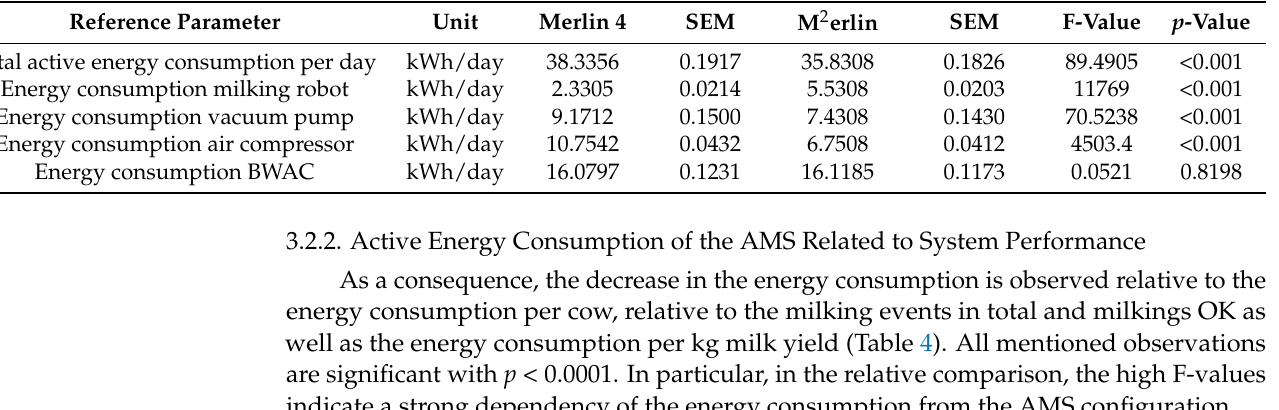
Table 3. A comparison of the daily active energy consumption of the Merlin 4 and M 2 erlin AMS